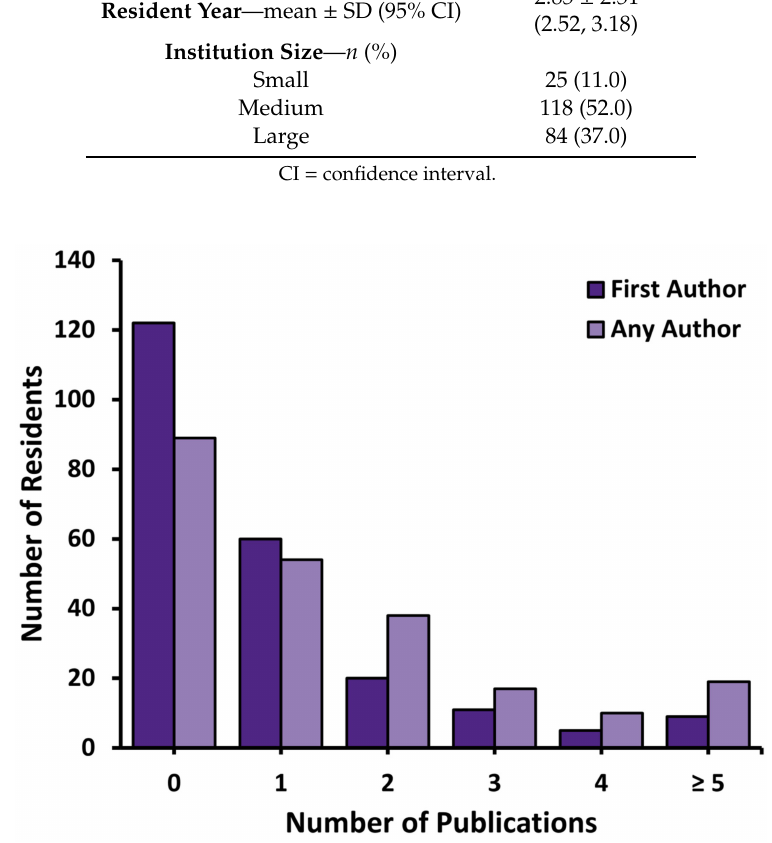
Figure 1. Number of publications per resident across all time periods. Table 2. Summary of the 8 most common journals for any radiation oncology (RO)-resident authored publications ( n =